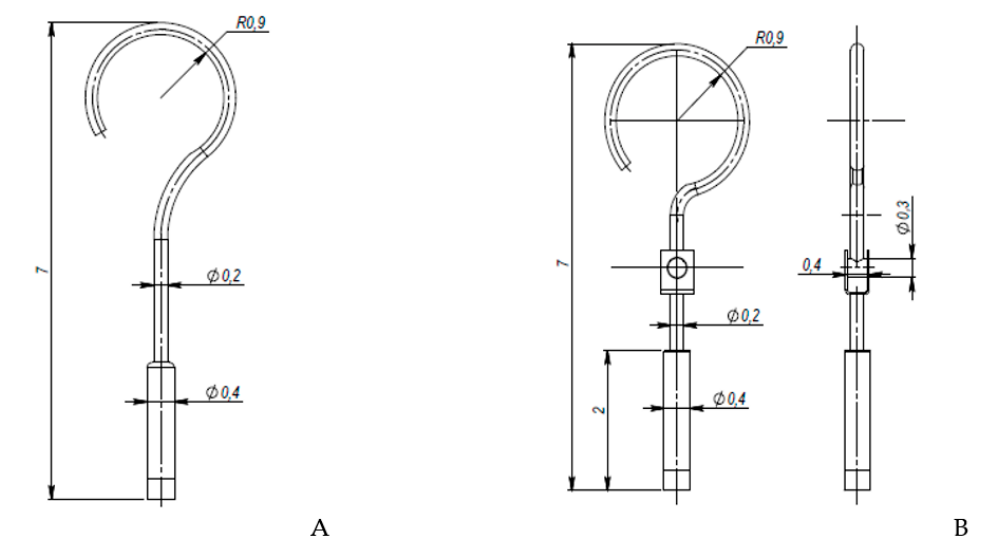
Figure 4. 3D CAD designs of stapes prosthesis. ( A ) standard, ( B ) modified with cylindrical joint. Finally, there were conducted two series of numerical analyses by changing the boundary conditions. Table 1 presents the calculation setup for eigenfrequency numerical analysis with boundary conditions, according to the standard stapes prosthesis placement and clinical situation. Correspondingly, 4 different numerical models were created, ac- cording to the boundary